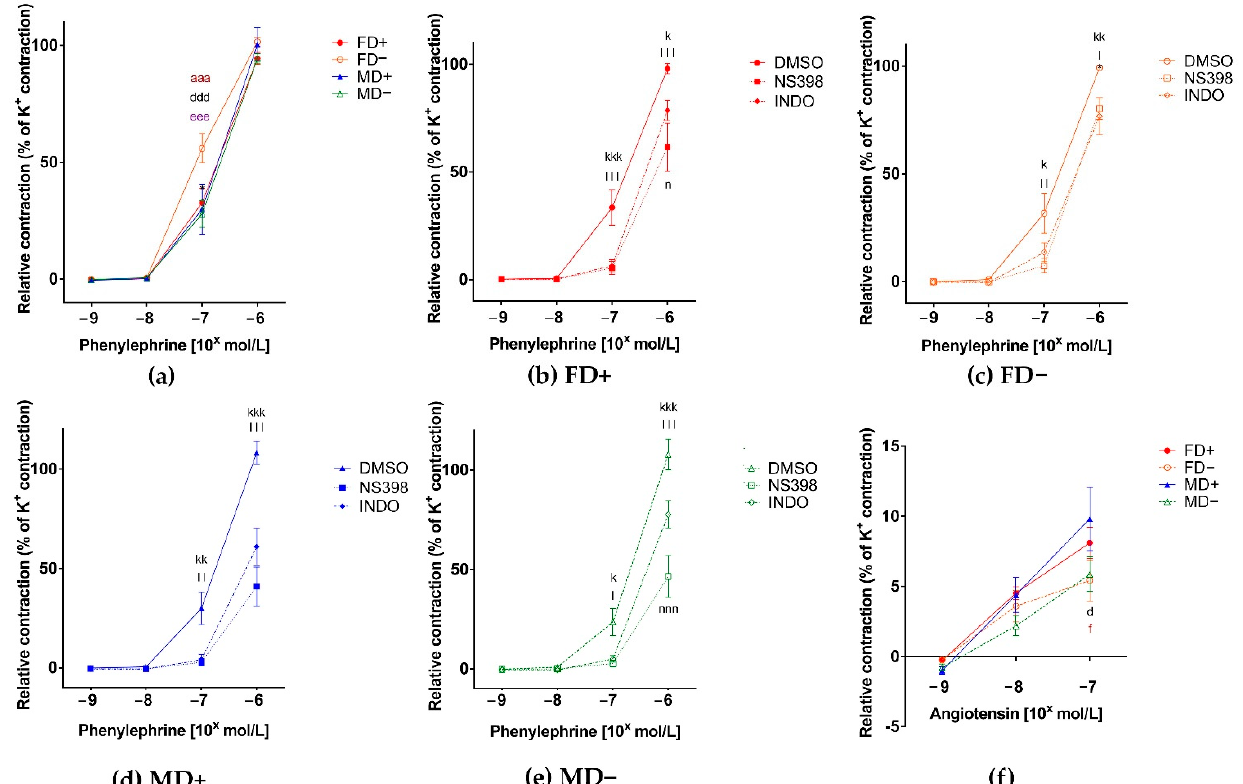
Figure 1. Contraction ability of isolated renal artery segments: ( a ) Phenylephrine (Phe) induced contraction. Vitamin D deficient female rats showed significantly increased contraction at Phe concentration of 10 − 7 mol/L compared to their Vitamin D supplemented and male counterparts. Data are shown as mean ± SEM; N = 8 in each group; aaa : p < 0.001 FD+ vs. FD– , ddd: p < 0.001 FD– vs. MD+, eee : p < 0.001 FD– vs. MD–; Phe-induced contraction in the presence of COX-2 inhibitor (NS398) or general COX inhibitor (indomethacin; INDO), or their vehicle DMSO ( b ) in female Vitamin D supplemented rats: Both general COX, and specific COX-2 inhibition led to decreased contraction that was more pronounced in case of specific COX-2 inhibition; ( c ) in female Vitamin D deficient rats: Both indomethacin and NS398 pretreatment resulted in reduced contraction force; ( d ) in male Vitamin D supplemented rats. Similarly to female